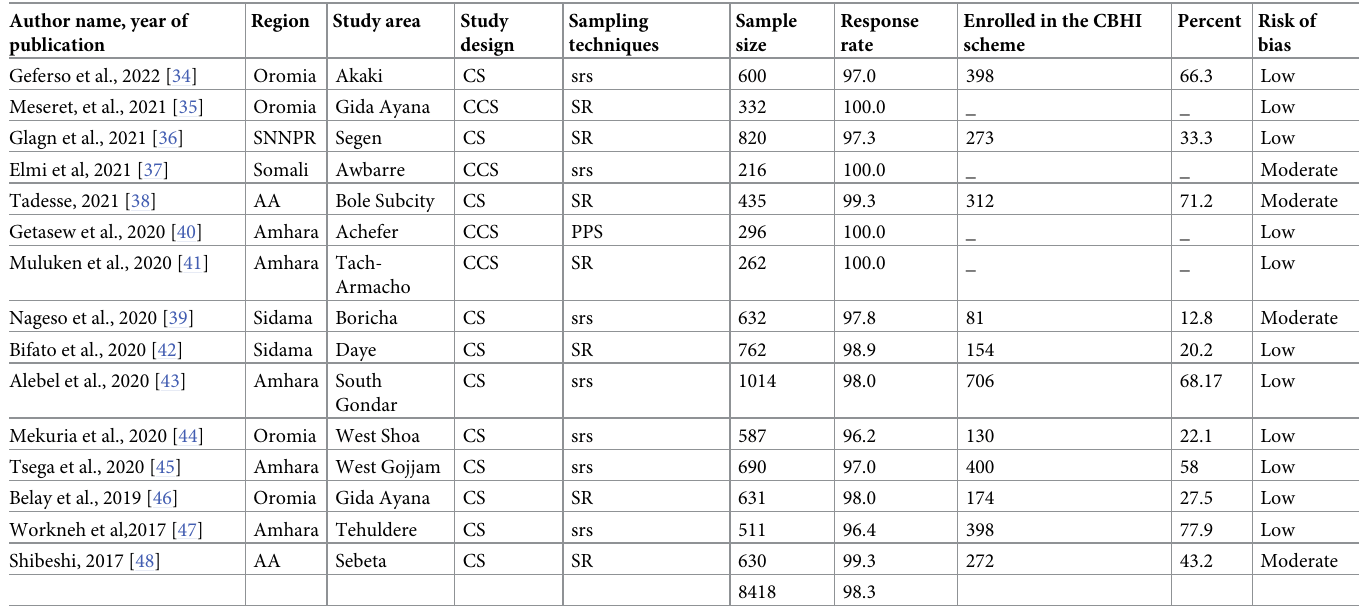
Table 1. Descriptive summary of studies included in systematic review and meta-analysis of CBHI enrolment and its determinants in Ethiopia, 2017–2022.